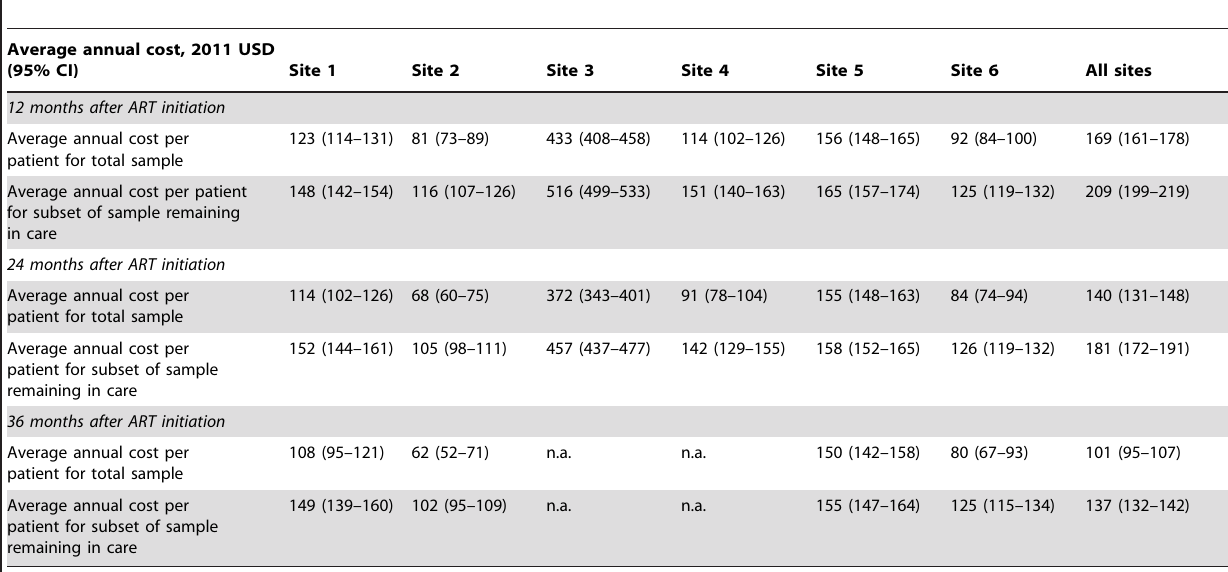
Table 3. Average annual costs at six ART treatment sites in Zambia by site and time on